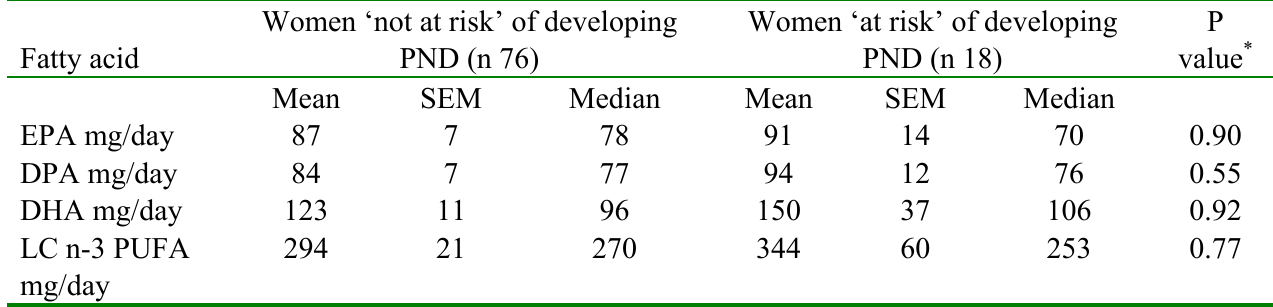
Table 4. Comparison of LC n-3 PUFA intakes between pregnant women ‘not at risk’ and ‘at risk’ of developing PND as assessed by the Edinburgh Postnatal Depression Scale 1